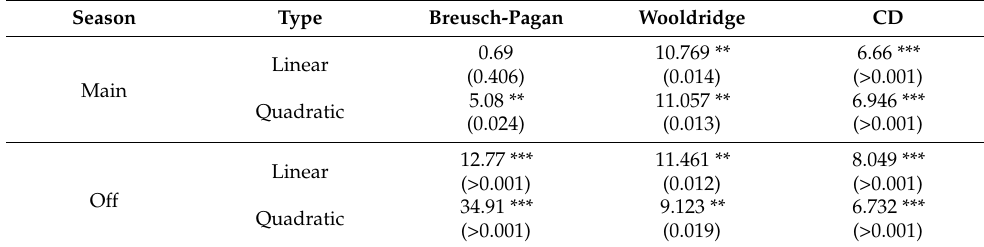
Table 6. Diagnostic test